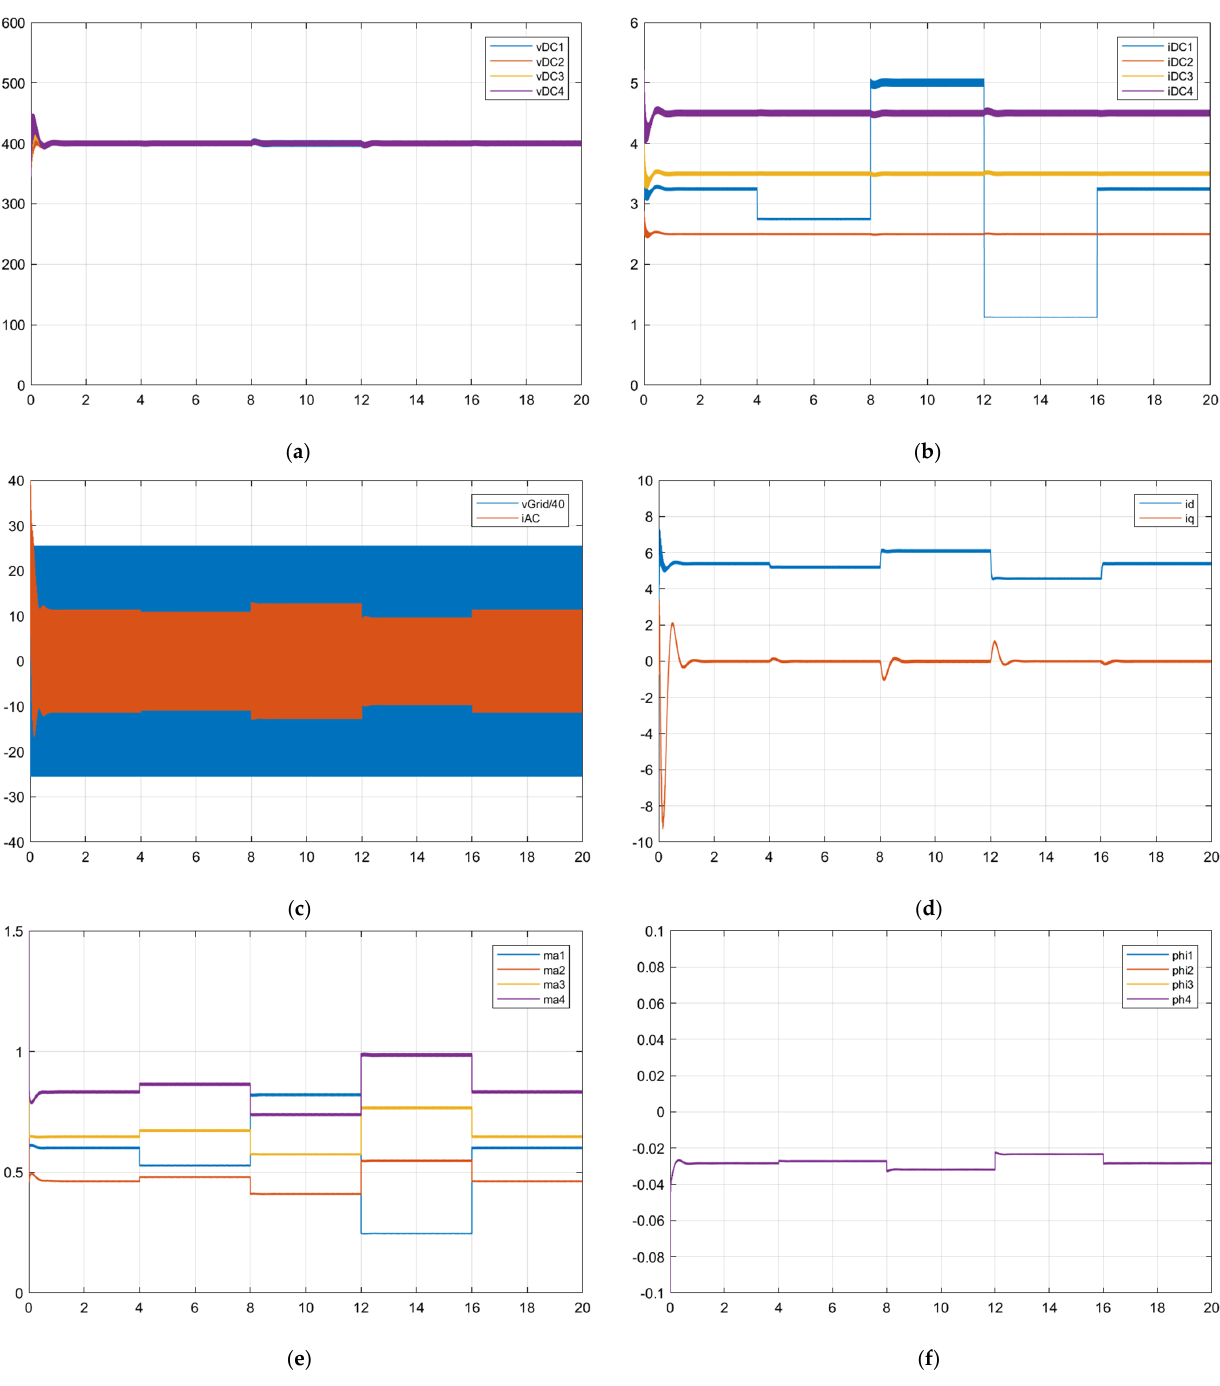
Figure 8. Simulation results when using normal operation (GUPF) strategy for case A: ( a ) PEB output DC voltage, ( b ) PEB output DC current, ( c ) grid voltage and current, ( d ) grid d–q current components, ( e ) PEB amplitude modulation index and ( f ) PEB modulation waveform phase.